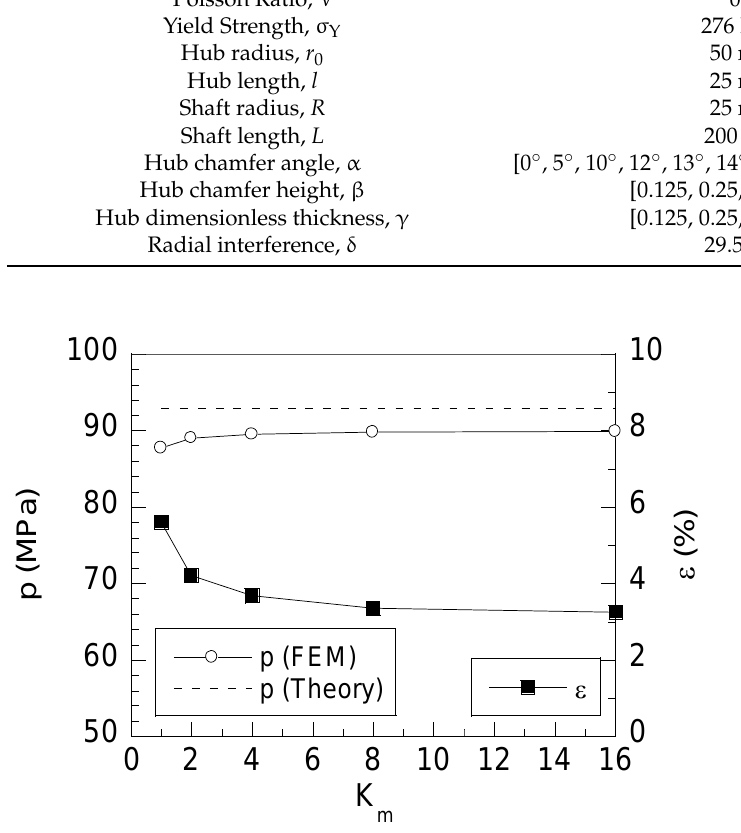
Figure 4. Mesh convergence analysis results.